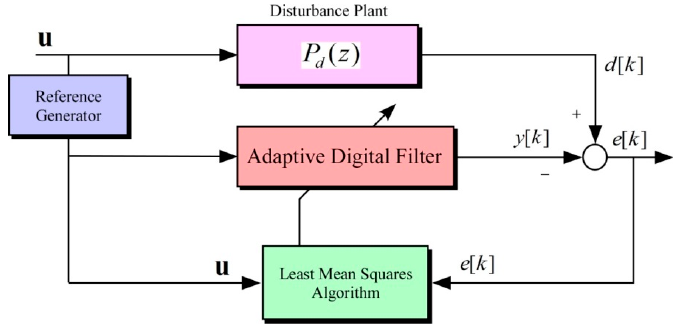
Figure 1. Typical adaptive digital filtering system.